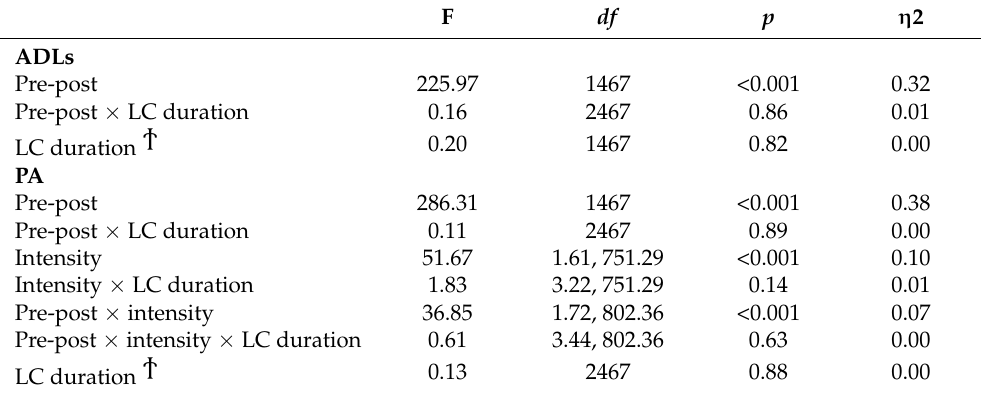
Table 2. A summary of the main effects from the repeated measures ANOVA.